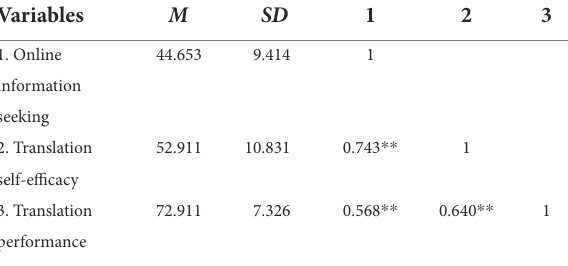
TABLE 2 Descriptive statistics and correlations for the study variables.